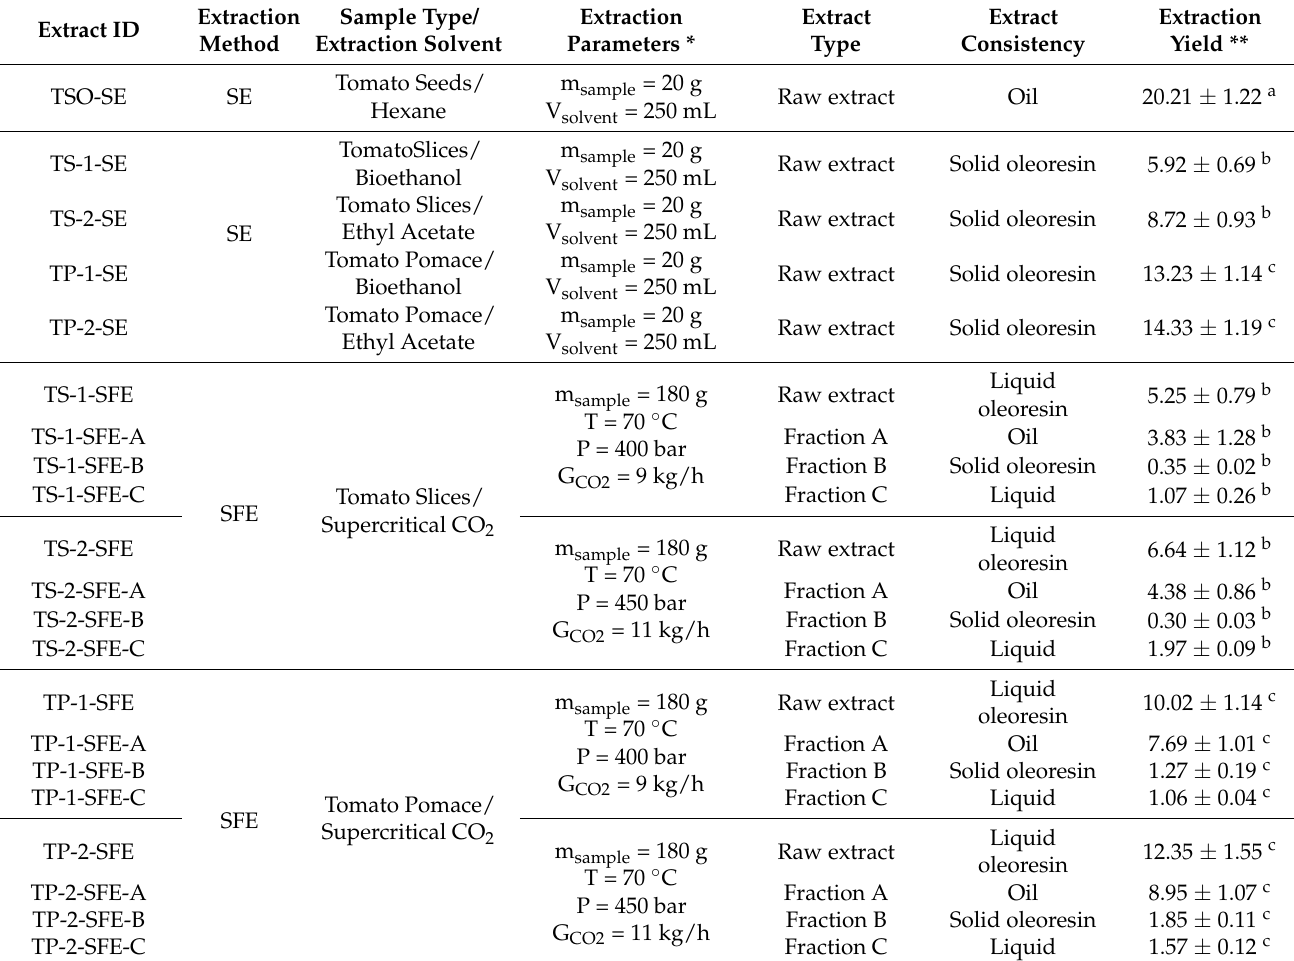
Table 3. Extraction yields of tomato samples (g extract/100 g dried tomato sample ±